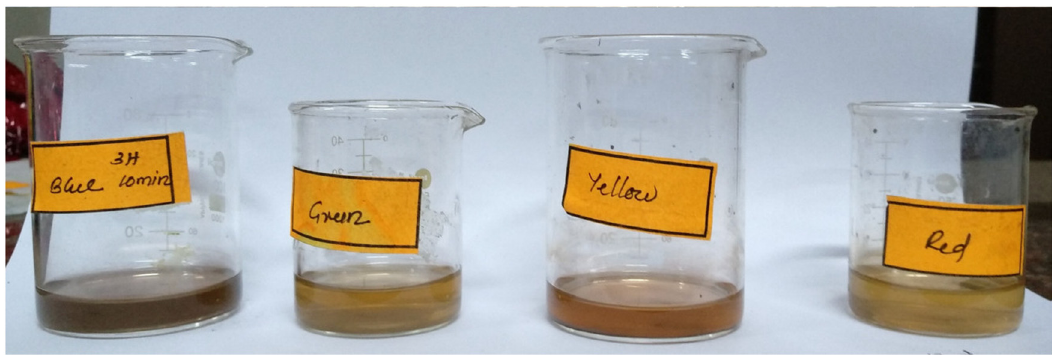
Figure 3: Color change of the solution mixture with the change in the wavelength of the incident light.